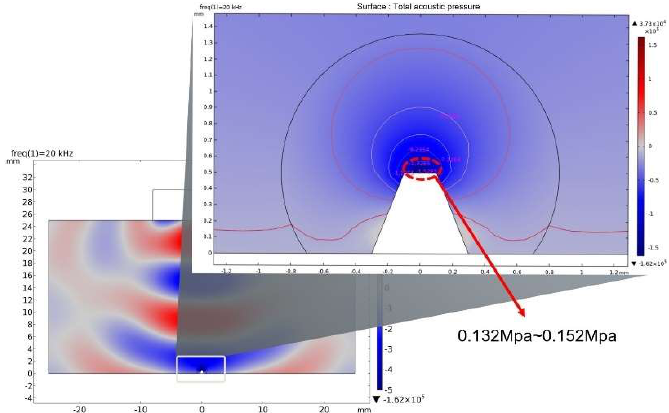
Figure 4. Acoustic pressure distribution of local ultrasonic cavitation field.